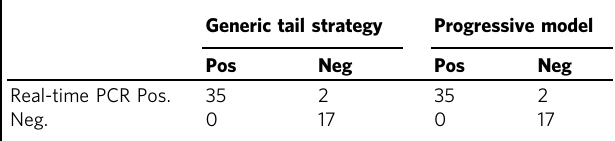
Table 1 Comparison of the patient samples assayed for HBV by real-time PCR, as a gold standard technique used clinically, and two isothermal ampli fi cation methods. (see Supplementary Table S3 for